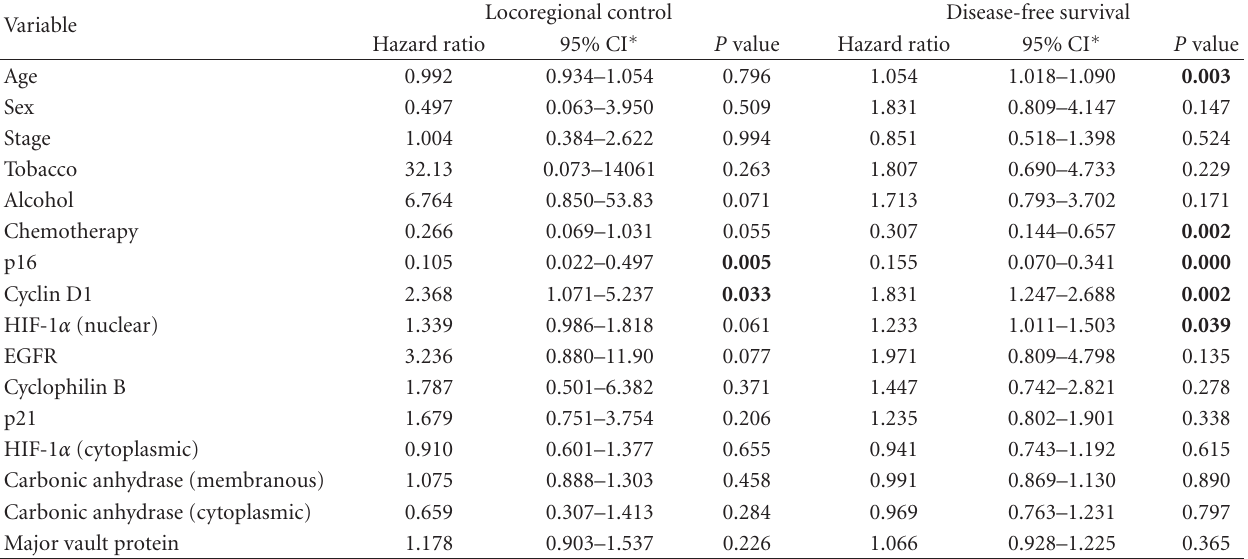
Table 3: Univariate Cox regression analysis.